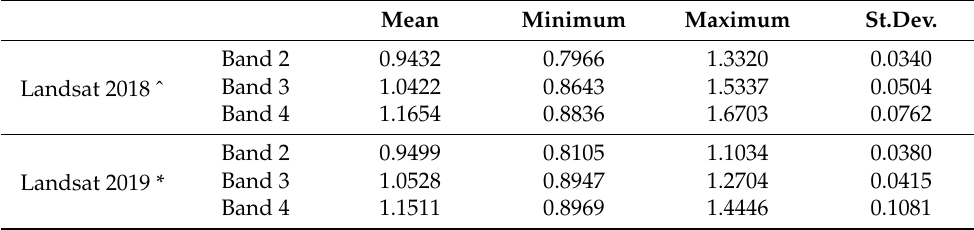
Table 2. Summary statistics of Landsat imagery comparison for 2018 and 2019 at same location.